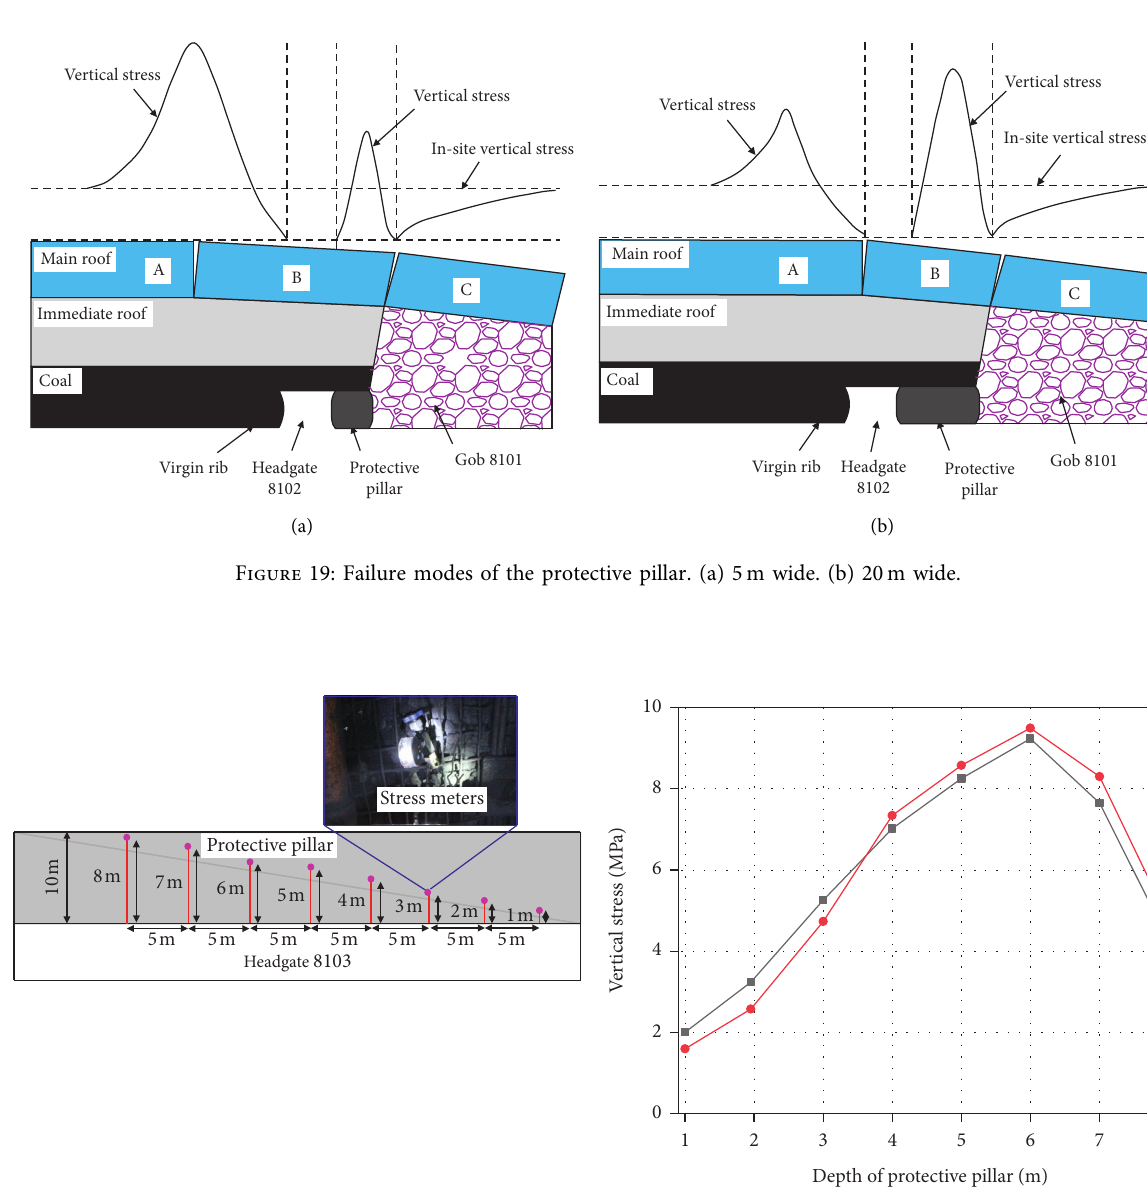
Figure 21. The deformation of the roadway became stable